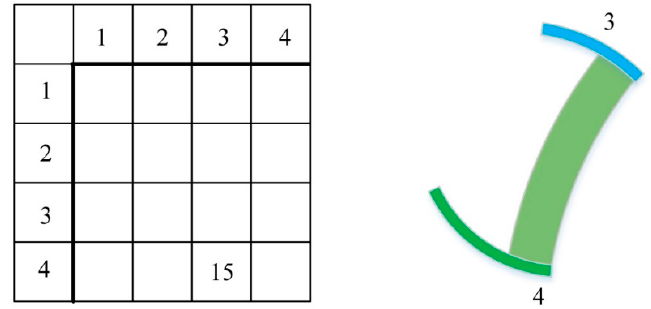
ff ects of origin–destination (OD)